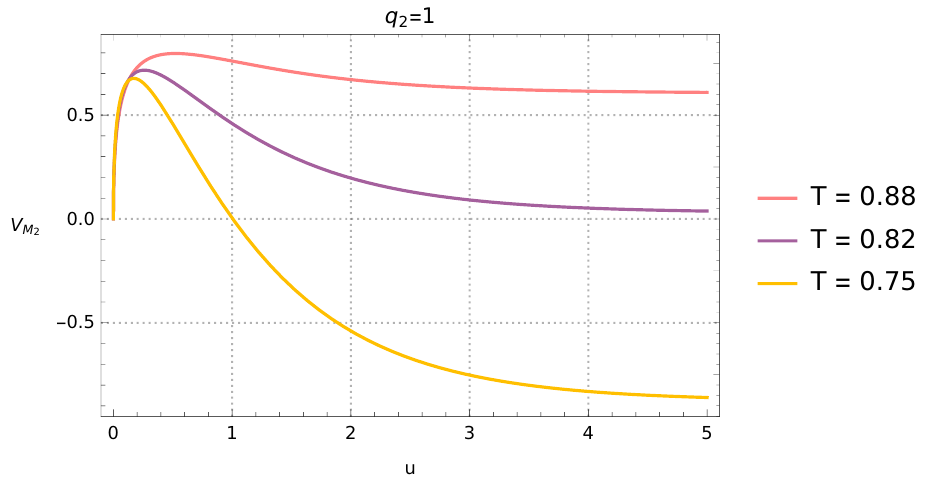
Figure 2 . M2 spacetime filling brane potential for the planar AdS 4 solution with R-symmetry field turned on. The value of Q is kept fixed, and the plot displays solutions with Q 2 Q 1 = 0 . 9 (violet) and Q 1 = 1 . 5 (yellow).